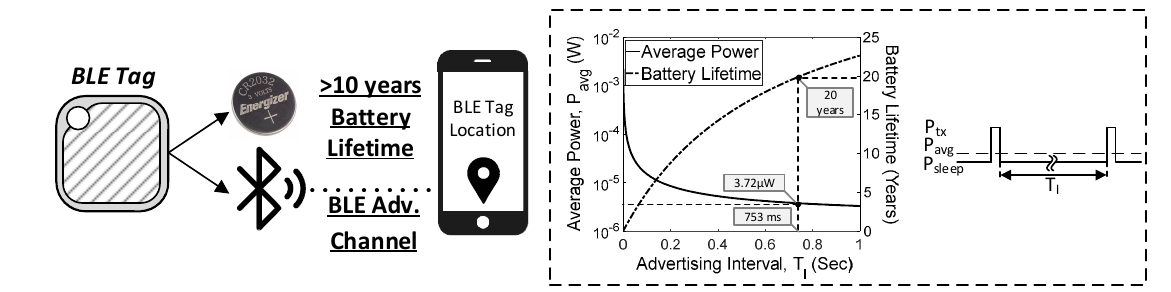
Figure 2. A typical IoT BLE application ( left ), the tradeoff between the required average power consumption and battery’s lifetime in duty-cycled transmission targeting a specific latency ( right ).